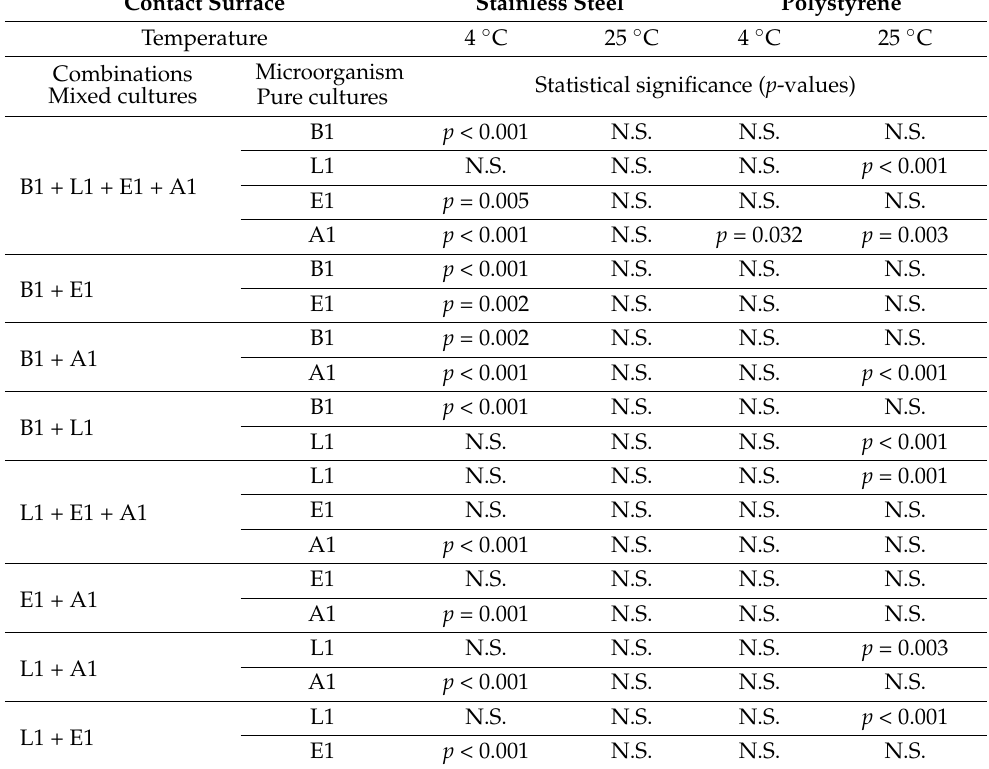
Legend: Significant differences are represented by the corresponding p -value. The absence of statistical differences was identified with N.S. (no